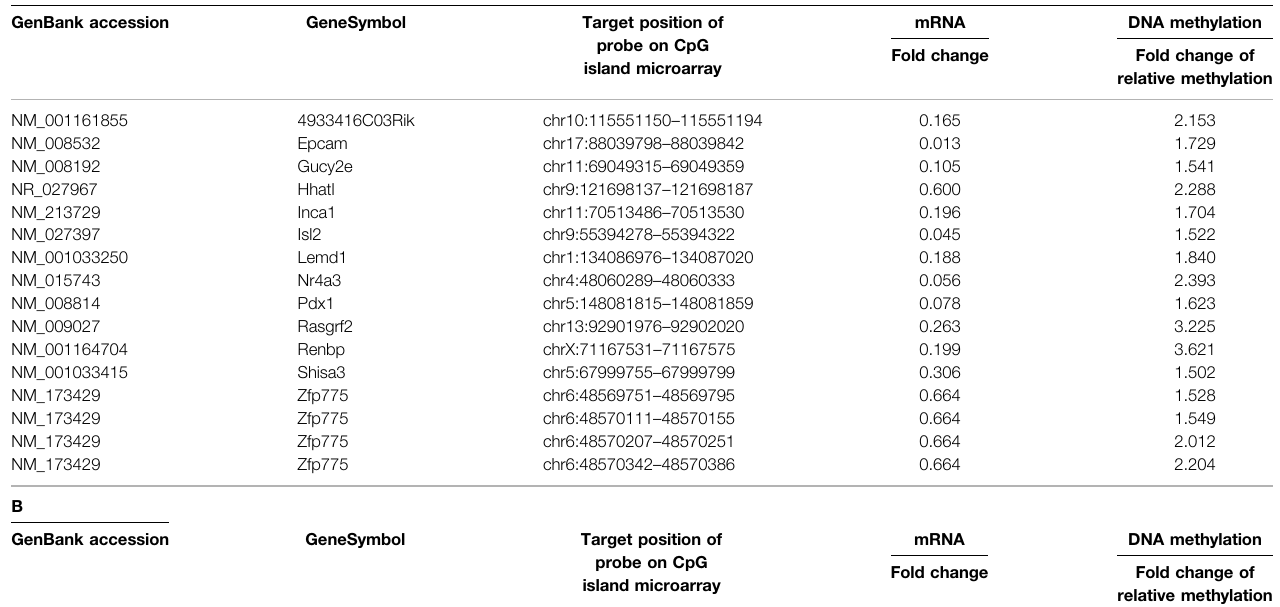
TABLE 2 | The genes of which expression levels were decreased with increased methylation of CpG island in the brain of male (A) and female (B)